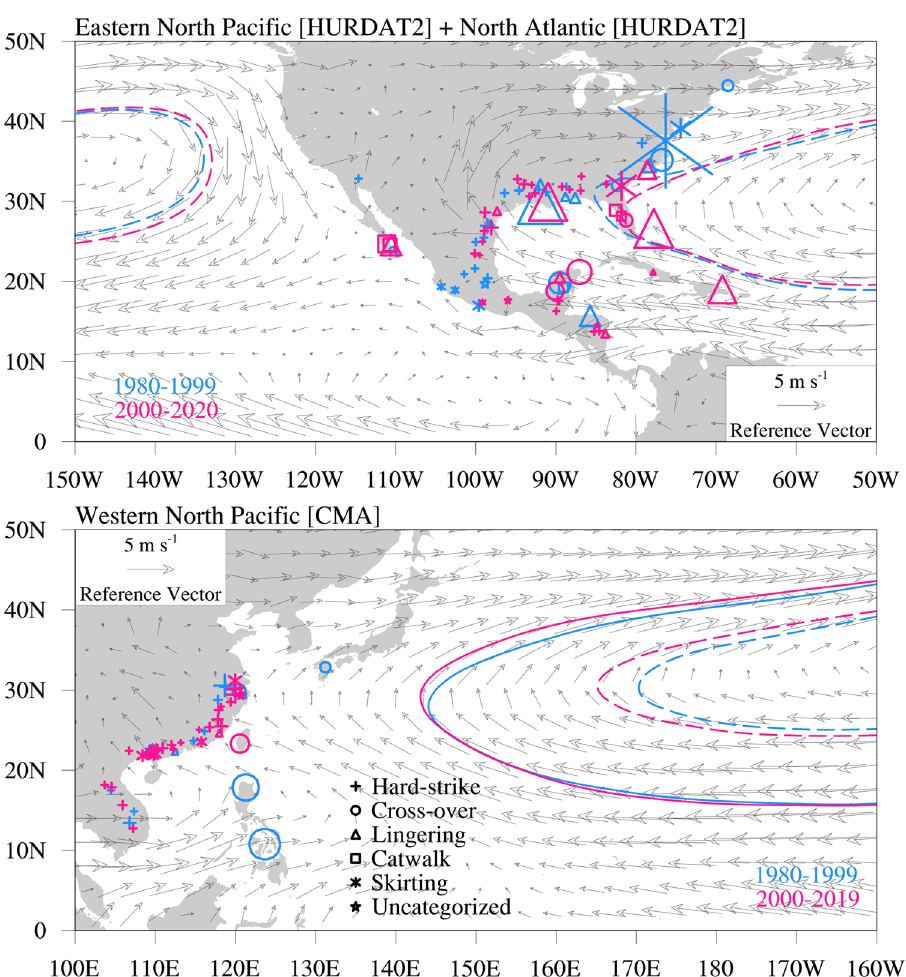
Fig. 5 Variations of subtropical highs and spatial distributions of landfalling track modes since global satellite era (1980 – 2019/20). Variations of subtropical highs are depicted by the 1520 geopotential height line (dash) at 850 hPa over the eastern North Paci fi c and North Atlantic, and by the 1490 (solid) and 1520 (dash) geopotential height lines at 850 hPa over the western North Paci fi c, with 40-yr mean wind vectors (July – October during 1980 – 2019) overlaid. Each marker represents the centroid position (the mean of tropical cyclone positions at four synoptic times past landfall) of an event in a particular landfalling track mode (speci fi ed in bottom panel; see Methods) with landfall intensity ≥ 64 kt, with its size proportional to the corresponding τ